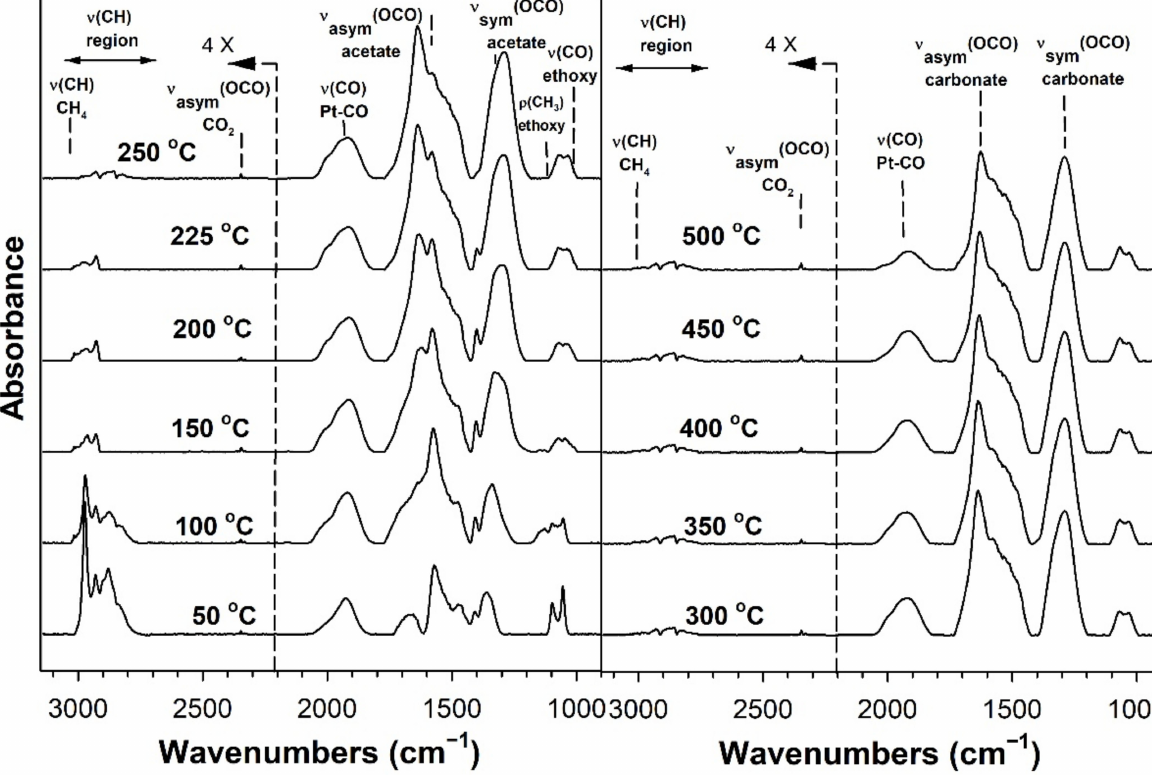
Figure 10. DRIFTS spectra of transient ESR over 4.65% Rb-2% Pt/m-ZrO 2